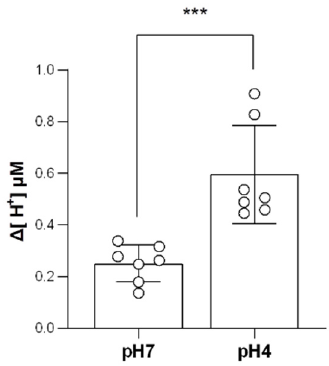
Figure 5. Effects of acid acclimation on the branchial H + -excreting capacity. The H + gradient at the gills of adult fish was measured by the SIET after 7 days of acclimation to acidic conditions. Values are the mean ± SEM (N = 7). Mann–Whitney U test, *** p < 0.001.